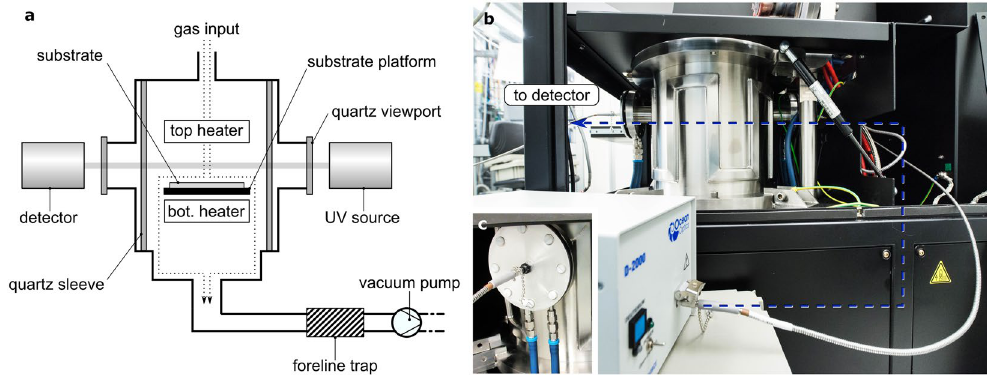
Figure 1. Illustration of the experimental setup. ( a ) schematic of the experimental setup, where a UV spectrometer is mounted on the cold wall CVD system so as to monitor the composition of the gases in the region directly above the copper catalyst layer; ( b , c ) photographs of the experimental setup; ( b ) fiber optic cables transmit light (blue dashed line) to and from the detector and UV lamp through the reaction chamber; the cables are attached to collimating lenses, which are firmly and precisely mounted onto the ( c ) front and back